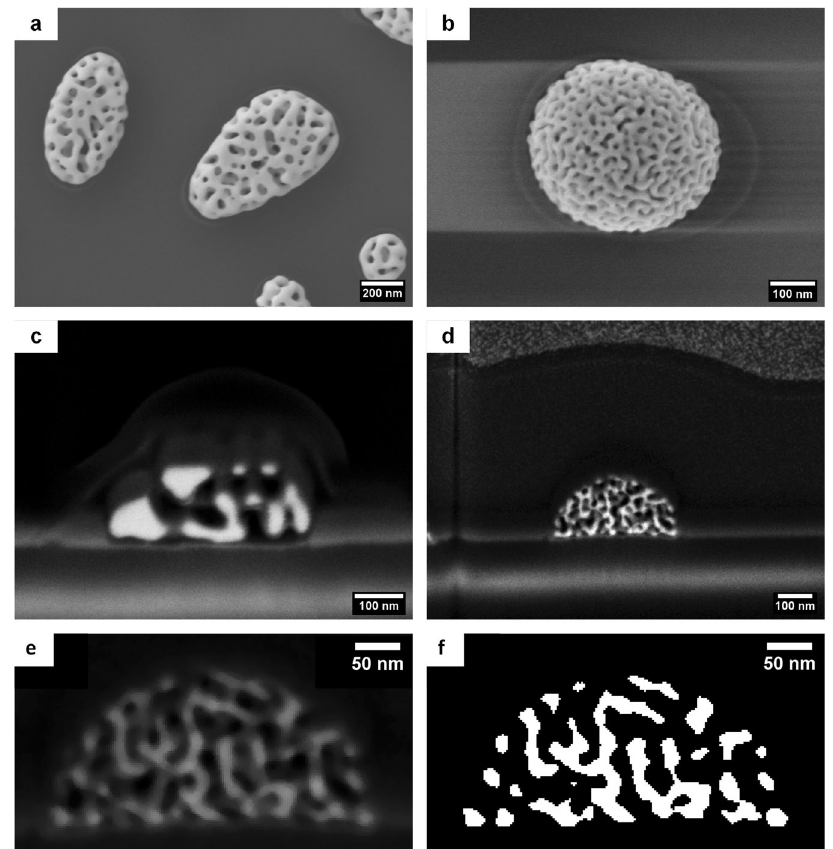
Fig. 1 SEM images of nanosponges. SEM images of particles on the substrate surface and cross-section images of a coarse-pored ( a and c ) and a fi ne- pored nanosponge ( b and d ). e Cross-section image of the the fi ne-pored sponge taken with the Inlens secondary electron (SE) detector. f Segmentation of the image e performed with a grayscale threshold of 60 in the 8-bit range.